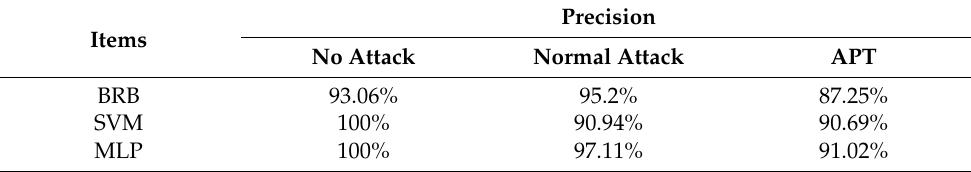
Table 12. The comparison of precision